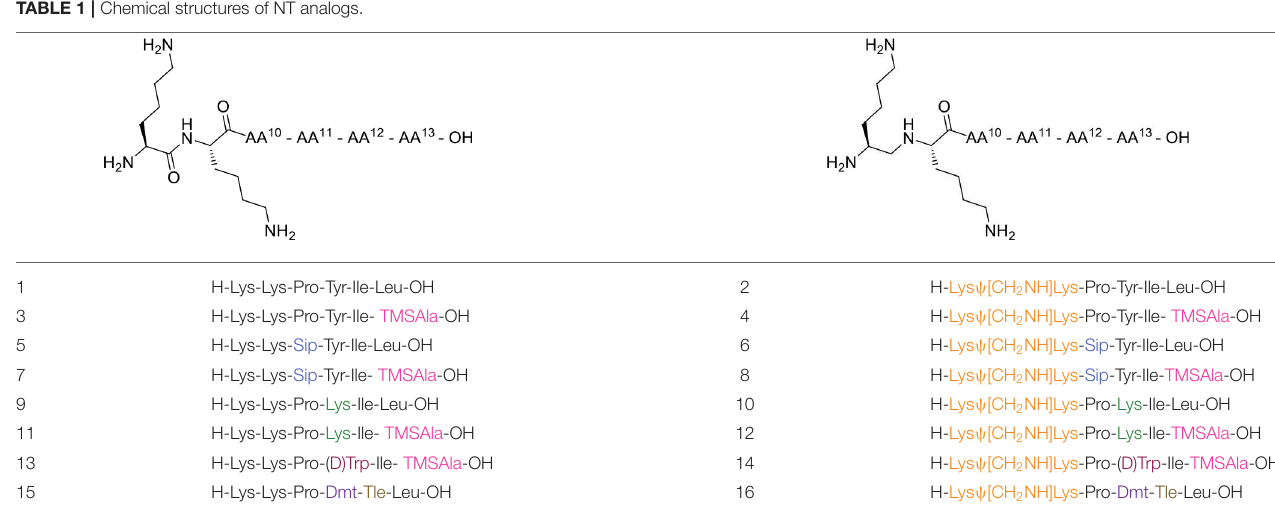
Frontiers in Chemistry |